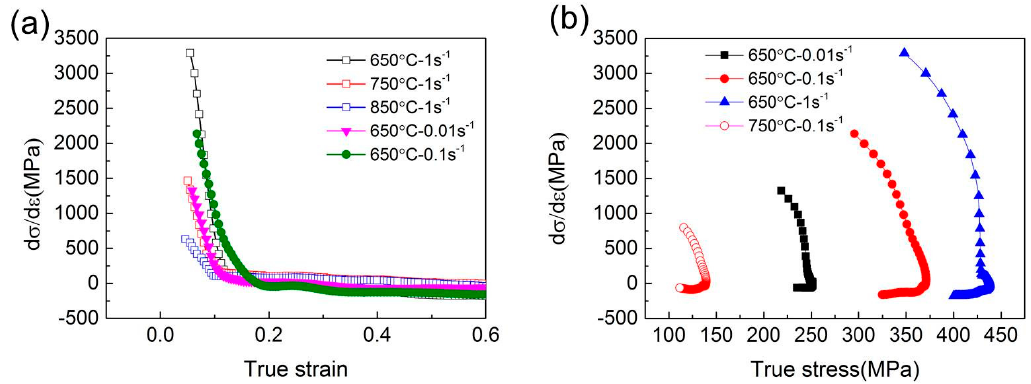
Figure 2. θ – ε and θ – σ curves of the Fe-6.5wt. %Si alloy: ( a ) θ – ε ; ( b ) θ – σ .